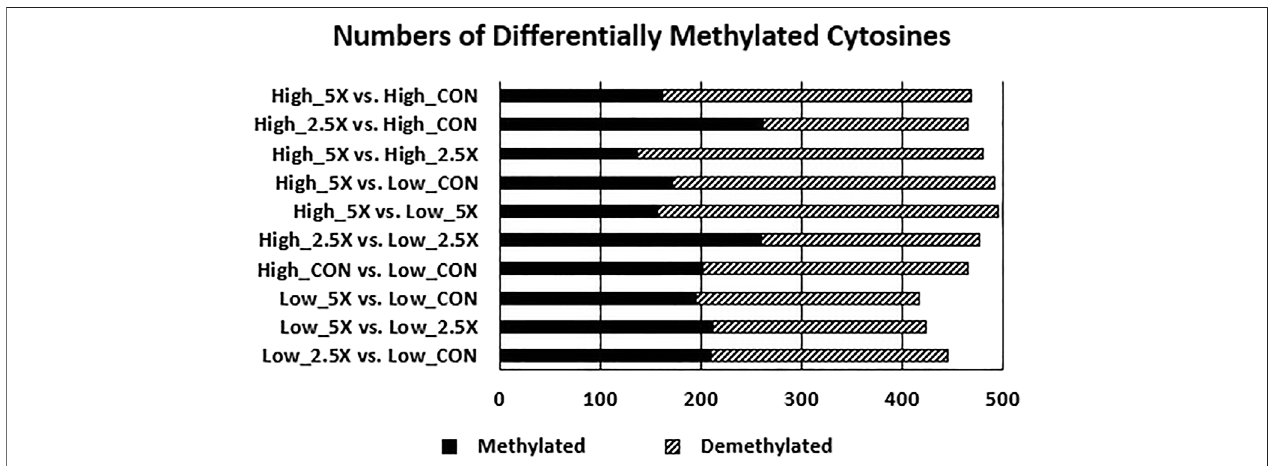
FIGURE 5 | Increasing epigenetic modi fi er (EM) supplementation decreases the number of methylated cytosines ( p < 0.01) of embryonic tracheal fi broblast cells across treatments. Data are presented as contrasts between treatments where the number of methylated and demethylated cytosines of the fi rst treatment listed are compared against the second ( i . e ., the number of differentially methylated and demethylated cytosines in the High ×5 treatment compared with the High Control treatment showing a greater number of demethylated cytosines compared with methylated cytosines in High ×5 compared with High Control). The differentially methylatedanddemethylatedcytosineswerede fi nedbasedonthesignofthelog2foldchange.Thenumberofdifferentiallymethylatedcytosinesarerepresentedbythe solid black bar. The number of differentially demethylated cytosines are represented by the dashed bar.